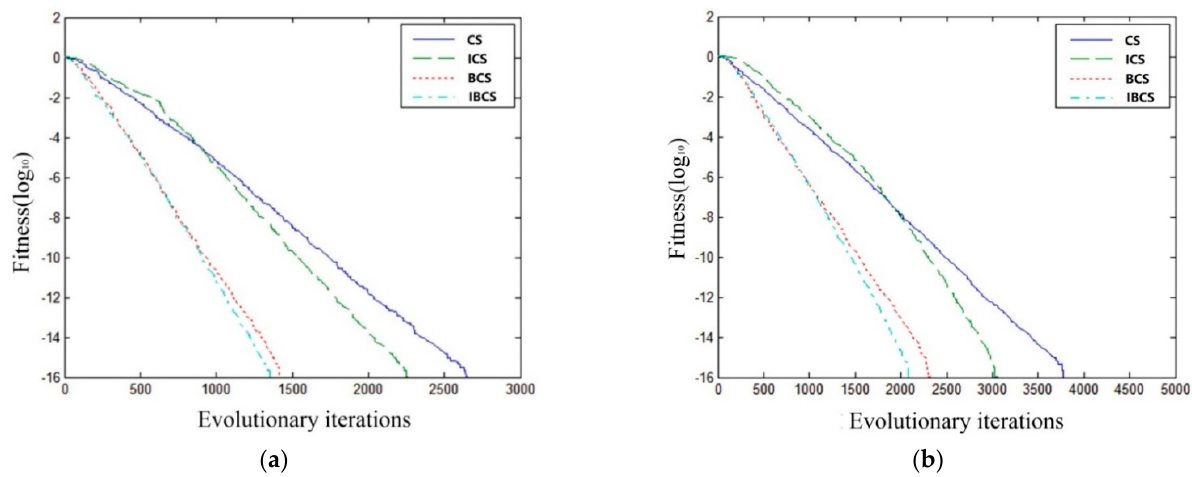
Figure 8. Comparison of the convergence results of the Griewank function; ( a ) 30 − dimensional; ( b ) 50 − dimensional.